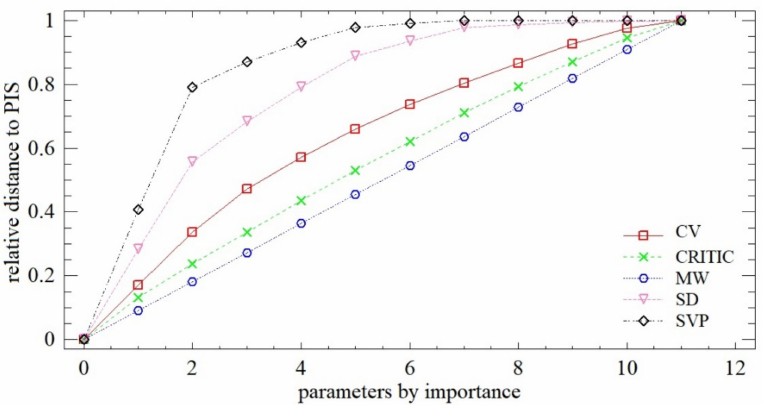
Figure 6. Cumulative frequency of weights within the individual methods (CV, CRITIC, MW, SD and SVP).